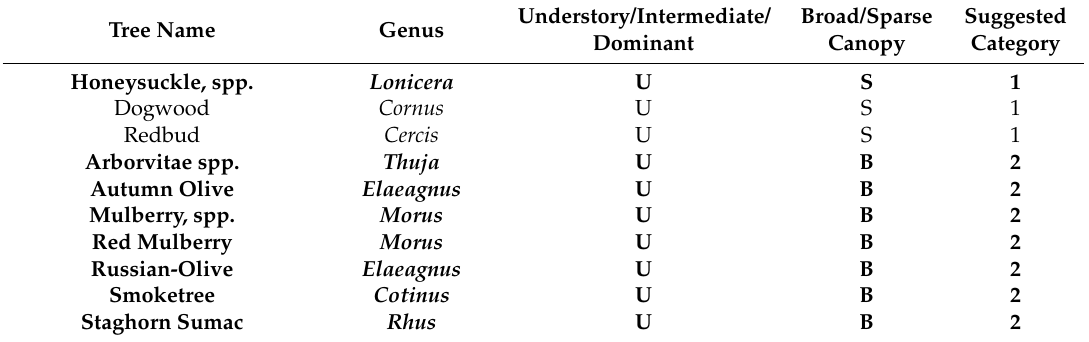
Table A1. The detailed suggested tree categories based on the degree of the resistance to air flow based on tree stature (understory, intermediate, or dominant) and crown density (broad or